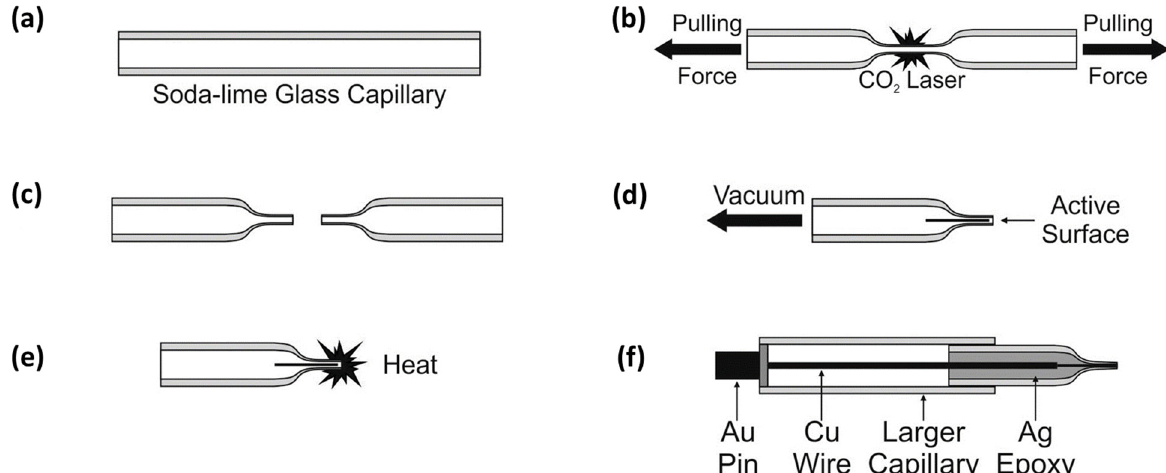
Figure 1. UME fabrication technique [39]: ( a ) bare soda-lime glass capillary, ( b ) heating the capillary with a CO 2 laser and pulling to form a sharp tip, ( c ) the two separated micropipette ends, ( d ) an electroactive wire is inserted into the micropipette and maneuvered to the tip before a vacuum tube is attached to the open end, ( e ) the electroactive wire is sealed in position under vacuum with a heating coil, and ( f ) the UME is finalized by adding the connective wires and the outer protective glass capillary. Adapted from ref. [39]. Copyright (2015) with permission from the American Chemical Society.